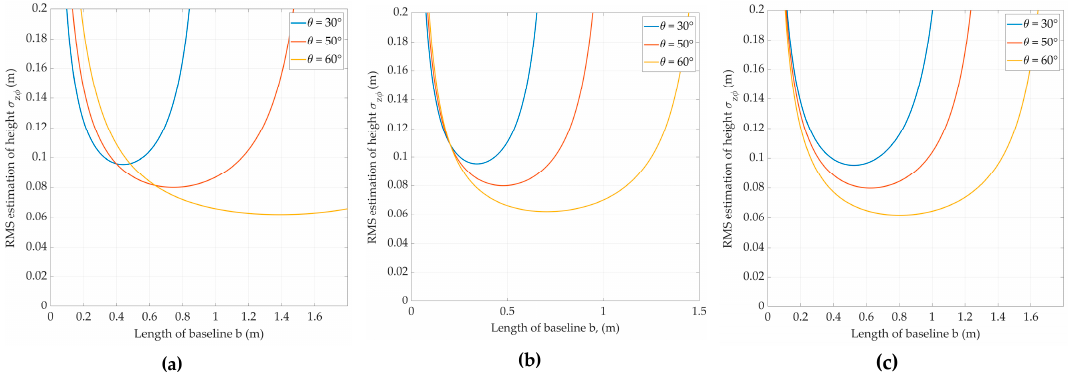
Figure 2. Height estimation error due phase estimation error on the baseline length at different look angles: ( a ) α = 0 ◦ ; ( b ) α = 45 ◦ ; ( c ) α = 90 ◦